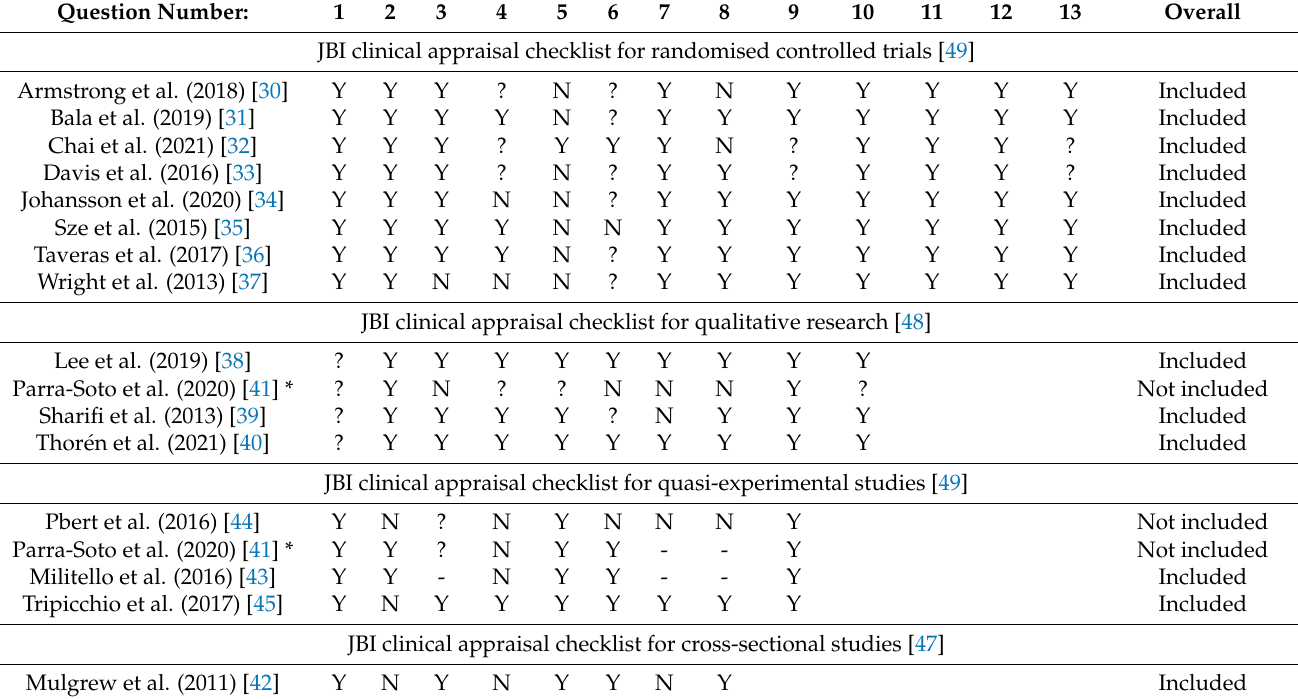
Table A2. Quality